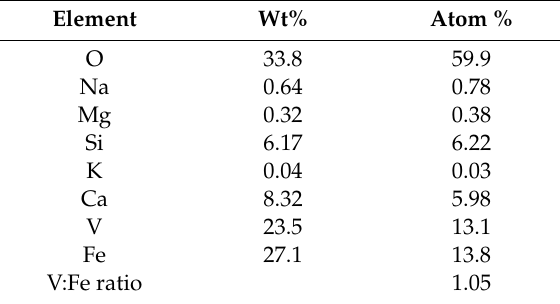
Figure 22. SEM/EDS spectrum of the vanadium mineral n silicified wood from the Monument #2 Mine. The carbon peak is perhaps indicative of small amounts calcium carbonate. The large Si peak is probably from the silicified wood. The Pd peak is an artifact from specimen coating to provide electrical conductivity. Table 3. SEM/EDS results for vanadium mineral from Monument Mine #2.